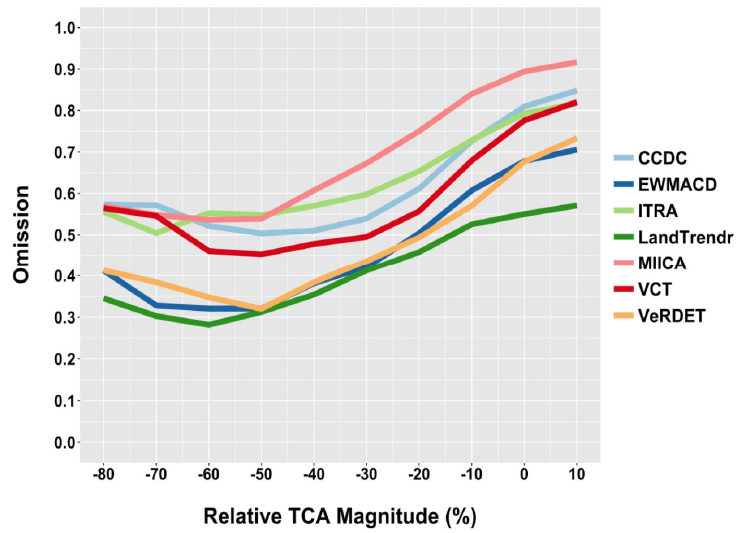
Figure 9. Omission for the seven map product sets as a function of disturbance relative change magnitude.